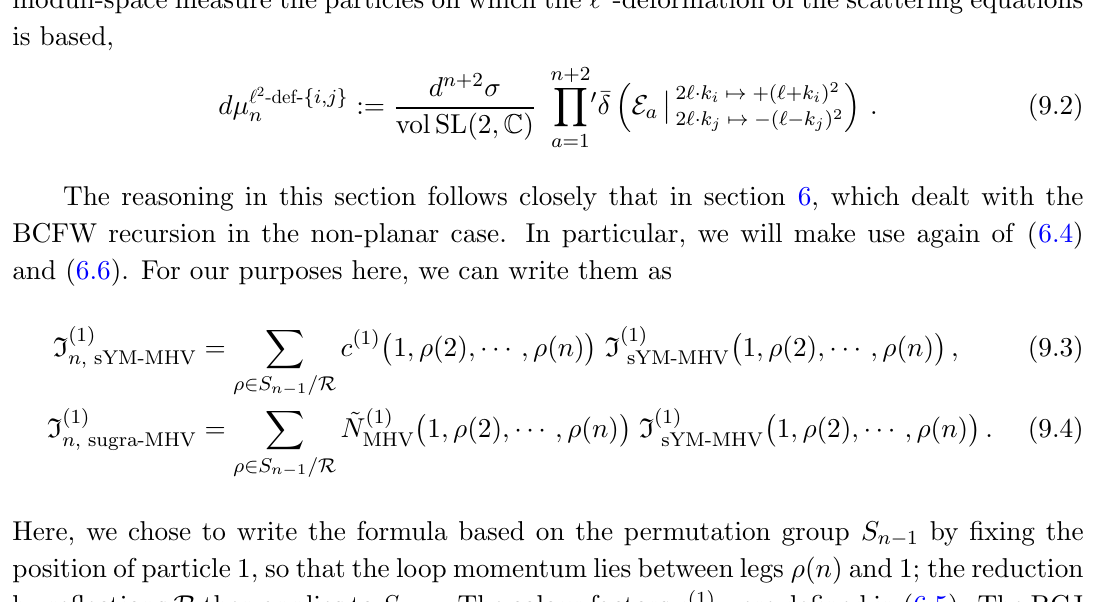
( z ) (cid:24) z (cid:0) 1 , and the boundary term thus sYM